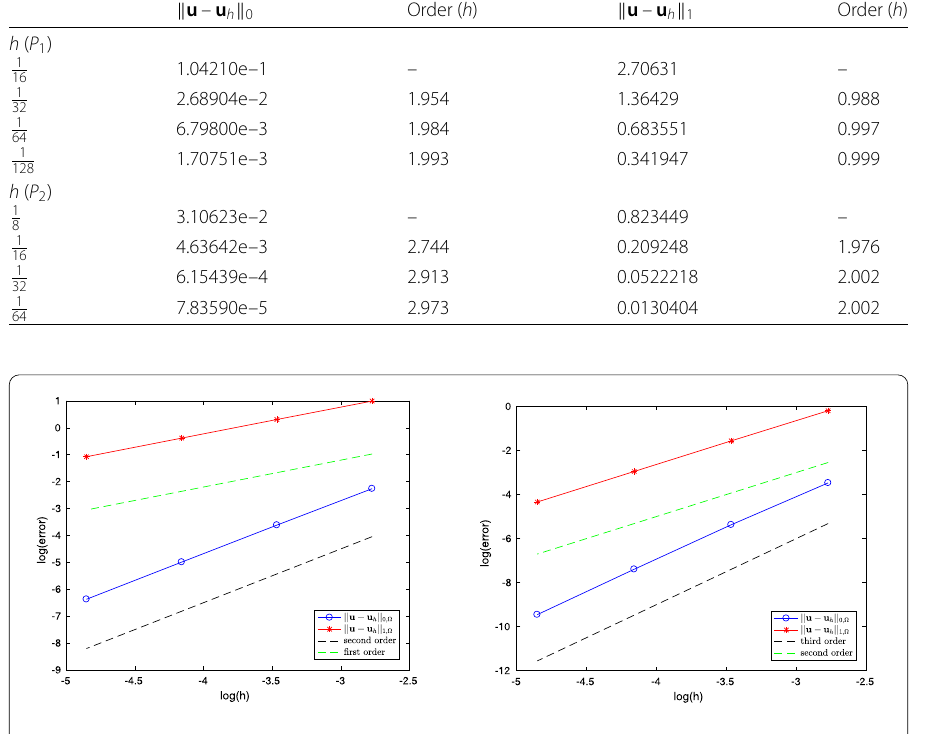
Figure 2 Plots of orders of convergence for Example 1. Left: P 1 elements; Right: P 2 elements Table 2 Convergence order with respect to h of the stabilized method for Example